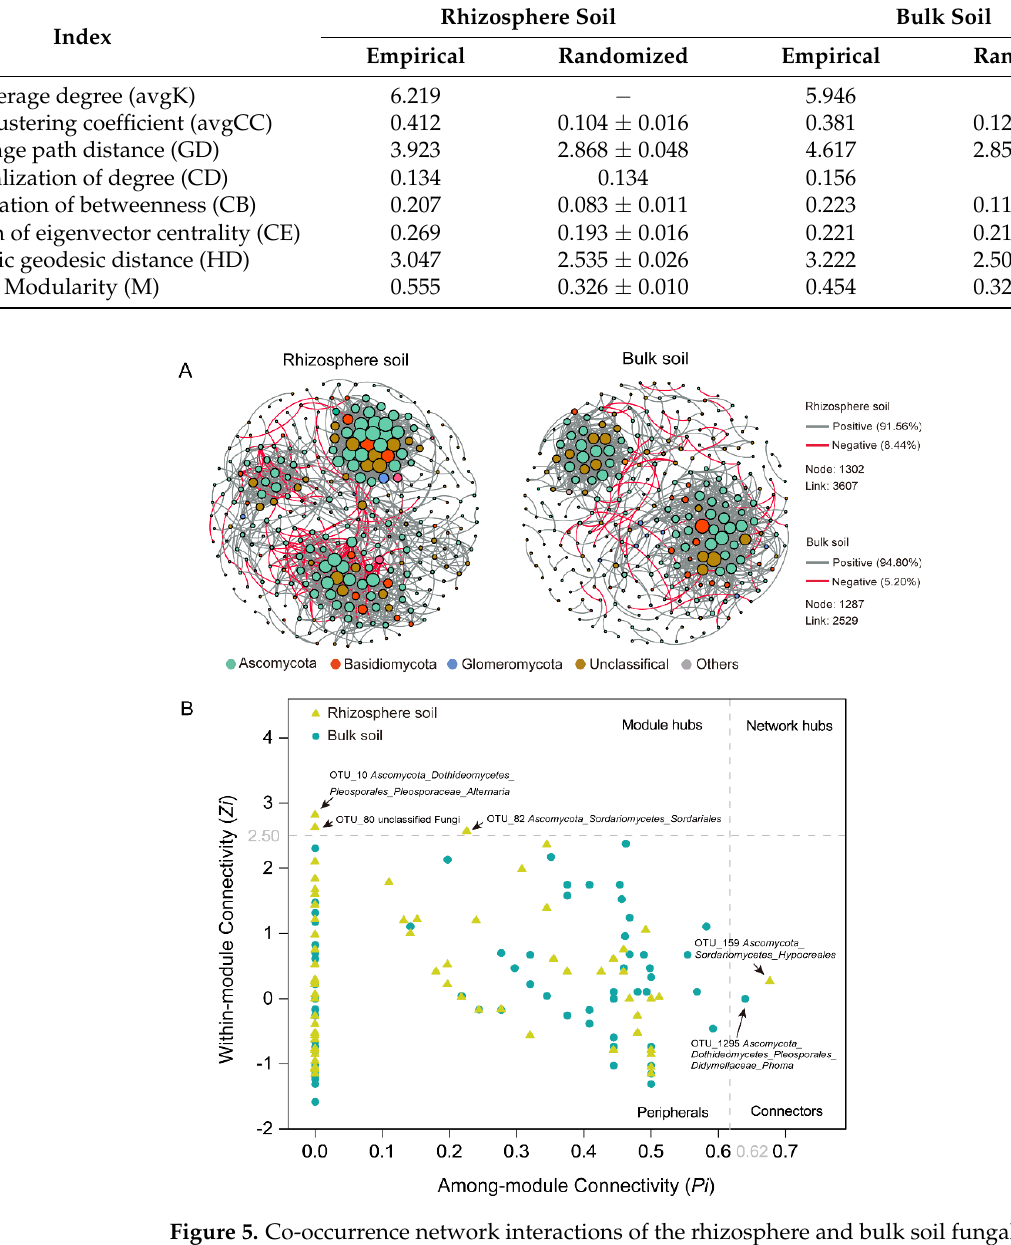
Table 3. Correlation coe ffi cients between module eigengenes and soil properties in the bulk and rhizosphere soils of the four selected halophytes. Bulk Soil